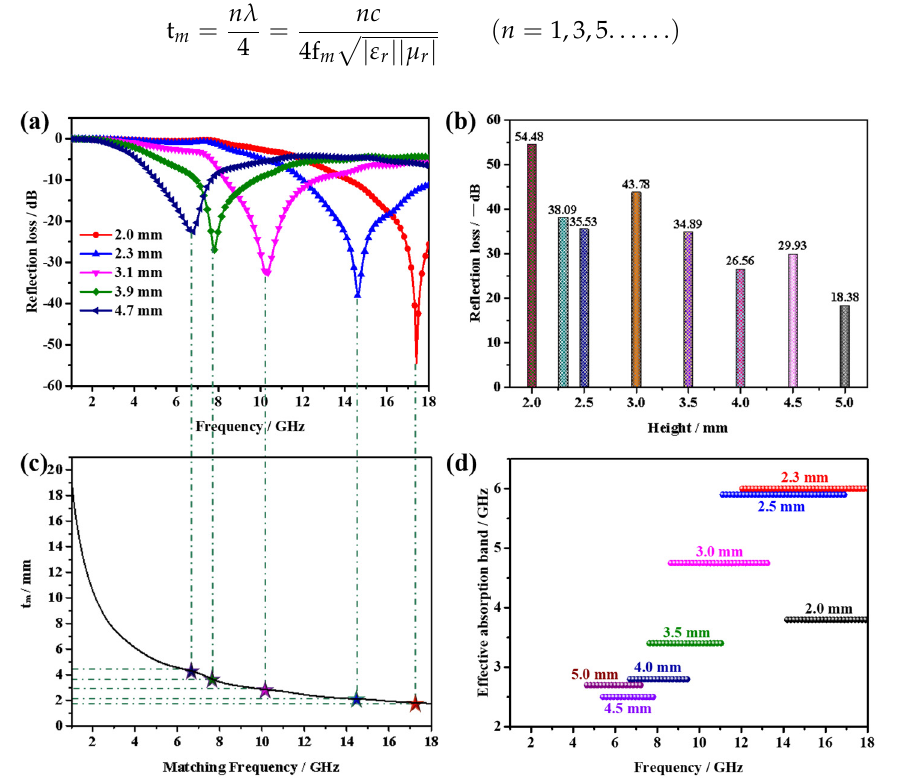
Figure 8. ( a ) Reflection loss curves of different thicknesses, ( b ) minimum reflection loss values of different thicknesses, ( c ) dependence of matching thickness (t m ) on matching frequency (f m ) at the wavelength of 1/4, and ( d ) Effective absorption band at different thicknesses of paraffin-based composites containing 20 wt.% CoS 2 hollow nanoboxes.